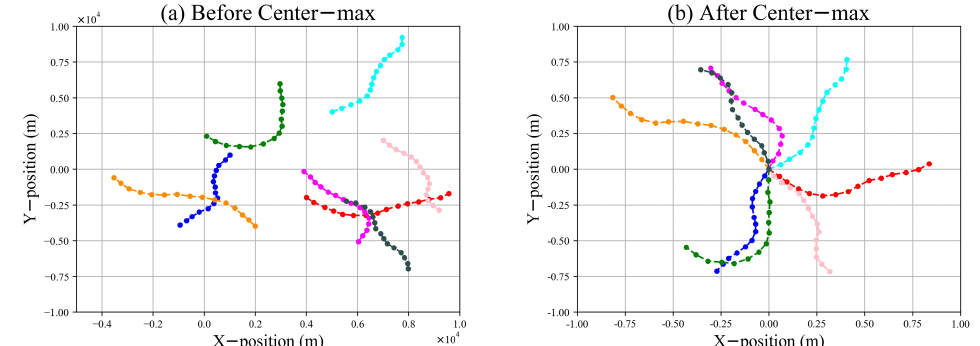
Figure 2. Center–max normalization. After center–max normalization, the distance ranges of the trajectories are transformed to [ − 1,1 ] and the differences in the initial positions of the trajectories are